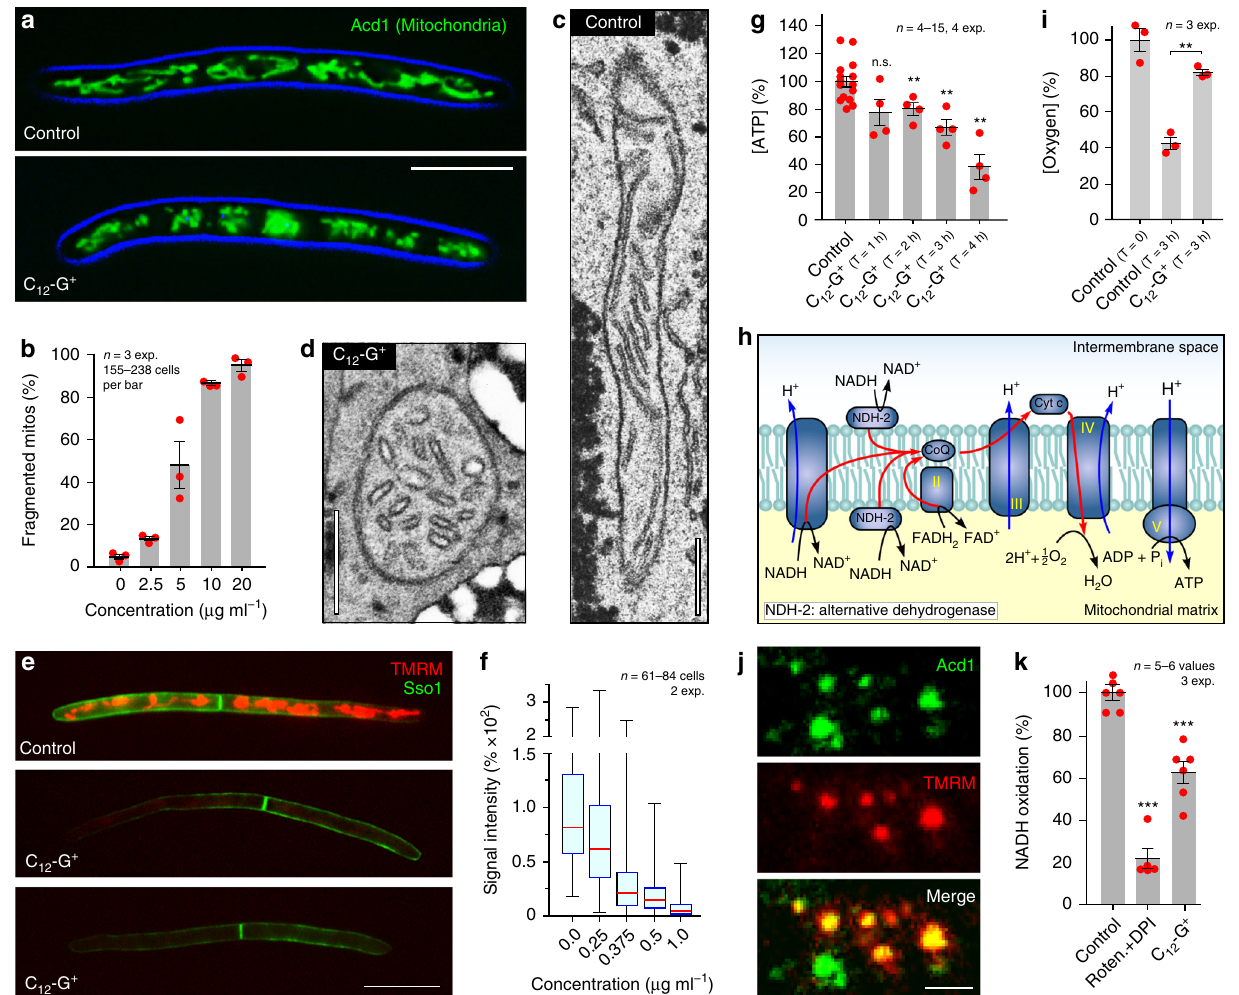
Fig. 2 The effect of C 12 -G + on Z. tritici mitochondria. a Mitochondria in Z. tritici in cells treated with solvent methanol (Control) and C 12 -G + . Organelles were stained with fl uorescent reporter proteins 33 . Scale bar = 10 µ m. b Bar chart showing C 12 -G + effect of mitochondrial fragmentation in Z. tritici . c , d Electron micrographs of mitochondria in methanol-treated Z. tritici (Control ( c ), C 12 -G + -treated ( d )). Note swollen cristae in C 12 -G + -treated cells. Scale bar = 0.3 µ m. e Mitochondrial membrane potential, visualized with TMRM, in Z. tritici cells treated with C 12 -G + . Scale bar = 10 µ m. f Bar chart showing effect of increasing concentrations of C 12 -G + on TMRM signal intensity, which re fl ects the mitochondrial proton gradient in Z. tritici cells. g Bar chart showing the relative amount of ATP in cell extracts, pre-treated for 1 – 4 h with C 12 -G + . h Schematic overview of the “ branched respiration chain ” of fungi. Note that NADH oxidation involves complex I, but also fungal-speci fi c alternative NADH dehydrogenases 11,12 . i Bar chart showing the consumption of oxygen of Z. tritici cells, treated with the solvent methanol (Control) and C 12 -G + . Dissolved oxygen in the medium was measured by Winkler titration. j Isolated mitochondria, labeled with the marker GFP-Acd1 33 (green) and stained with the potential dye TMRM (red). Scale bar = 1 µ m. k NADH oxidation measured in isolated mitochondria, treated with C 12 -G + . Values ( b , g , i , k ) are shown as mean ± SEM. Red dots represent data points. f Shows Whiskers ’ plots, with 25th/75th percentiles (blue lines), medians (red line), and minimum and maximum (whiskers ends). Sample size n is indicated in each